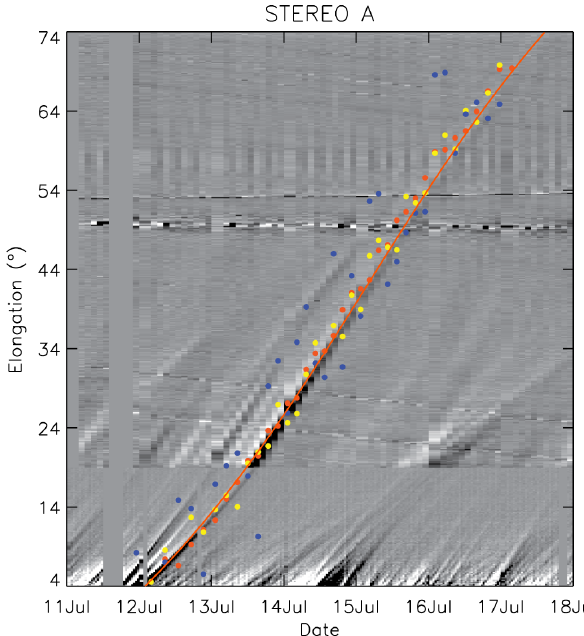
Fig. 3. A close up view of one of the features seen in Fig. 2, with three sets of points overlaid simulating three levels of accuracy with which a person can track the feature. The orange, yellow and blue dots mark sets of normally distributed points with standard devia- tions of 1, 2 and 5 ◦ , respectively, around those points determined theoretically for a solar transient with V r =320kms − 1 and β =48 ◦